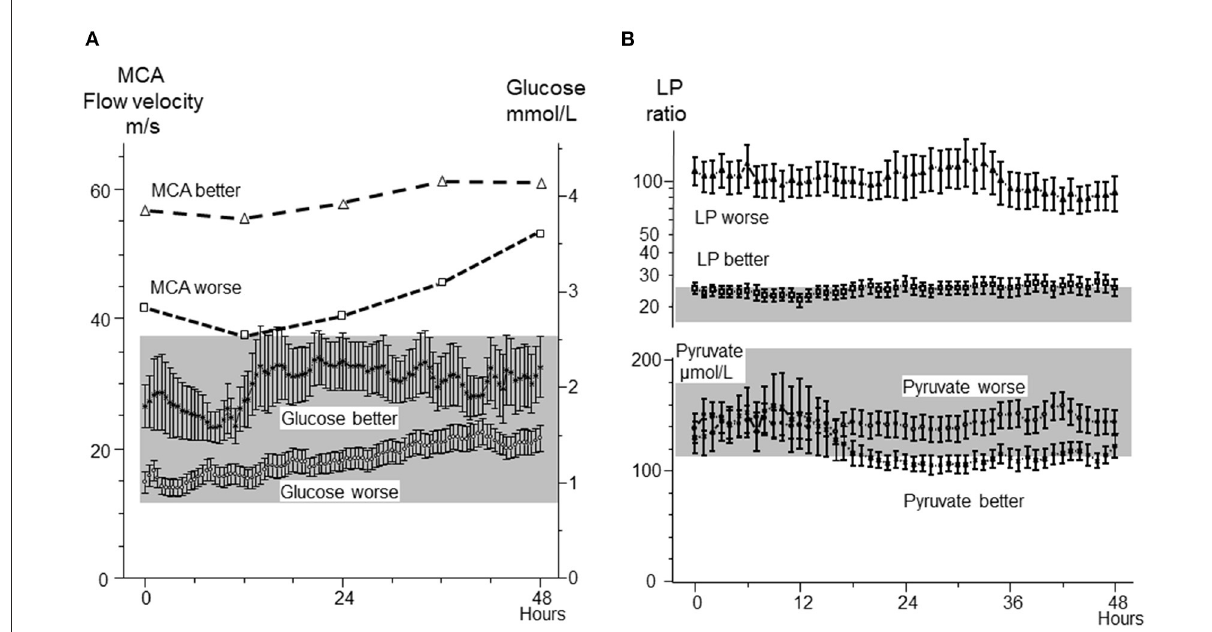
FIGURE7 (A): Middle cerebral artery (MCA) blood-flow velocities in the infarcted (worse) and non-infarcted (better) hemisphere and cerebral interstitial glucose concentration in infarcted (worse) and non-infarcted (better) hemisphere following hemicraniectomy. (B): Cerebral interstitial levels of lactate/pyruvate (LP) ratio and pyruvate in the infarcted (worse) and non-infarcted hemisphere (better) after hemicraniectomy. The normal ranges for intracerebral glucose and pyruvate (Mean ± 2S.D.) (41) are indicated by the gray areas. Biochemical data from (89, 90) are shown as Mean ±